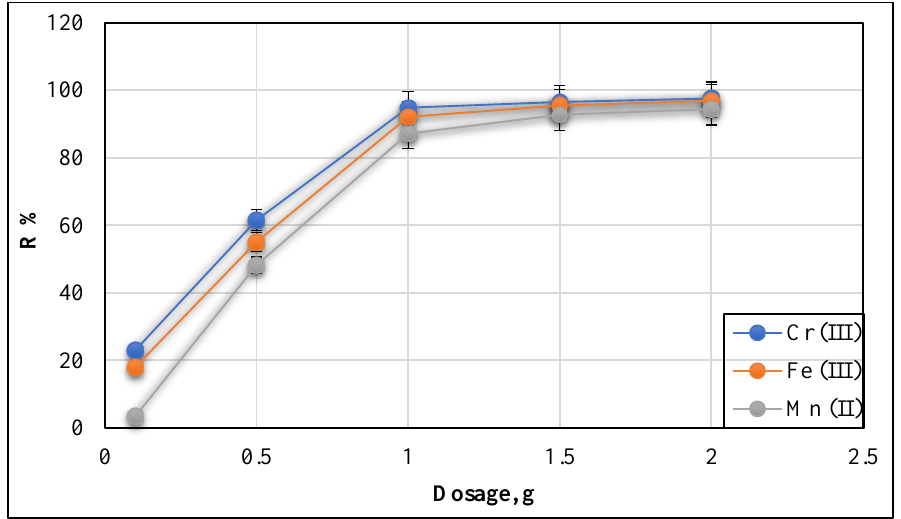
Figure 14. Adsorbent Ch/g-HNTs@Zn M dosage versus removal % of Cr (III), Fe (III), and Mn (II).